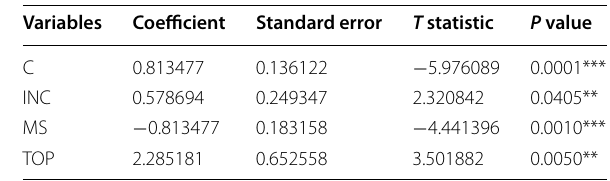
Table 9 Estimated long-run coefficients using the ARDL approach for job creation